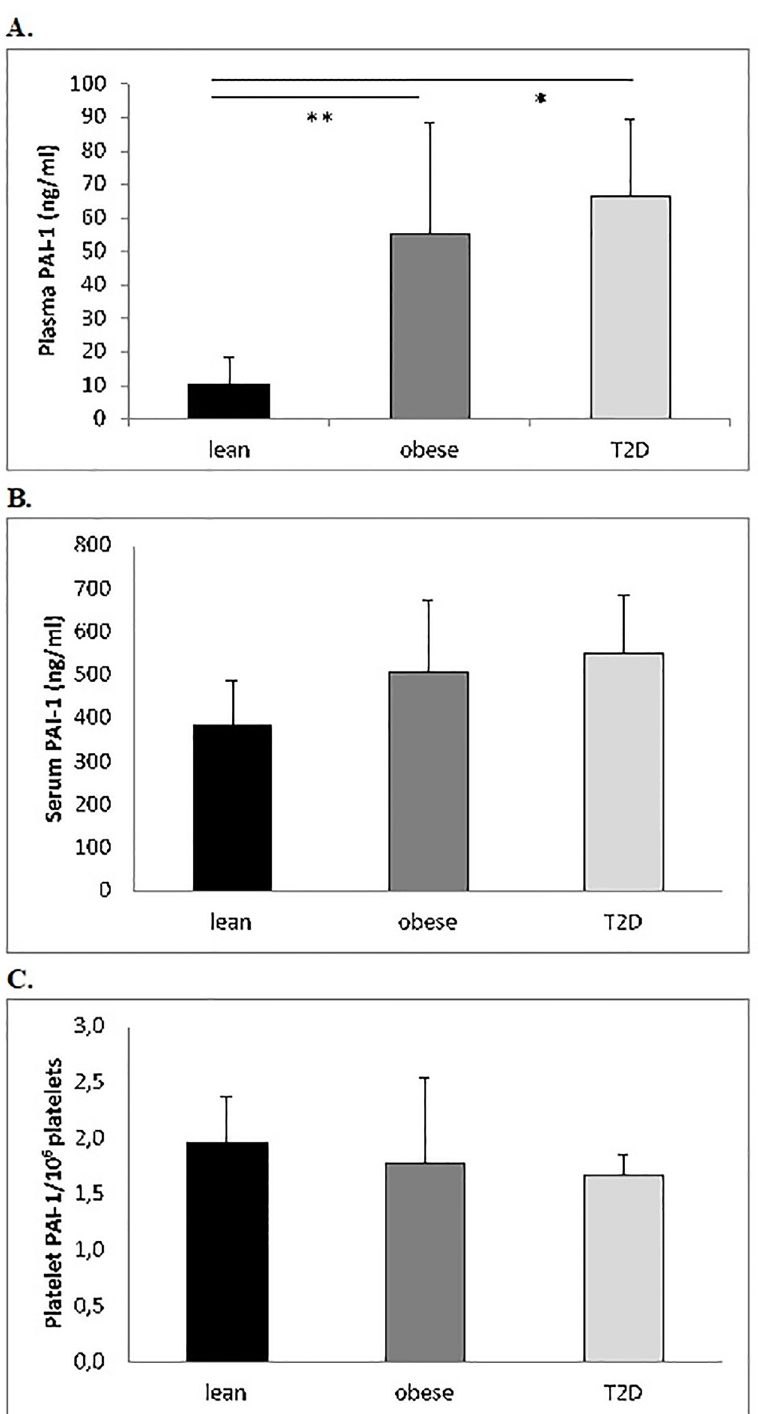
Fig 1. Pool of PAI-1 in A. plasma, B. serum and C. platelets in T2D patients, lean and control participants. There was a significant increase of plasma PAI-1 in participants with T2D and obese non-diabetic control subjects compared with lean control subjects (T2D n = 6, obese n = 7 and lean control subjects n = 8). � P ˂ 0.001, �� P ˂ 0.001. B. No significant difference in serum PAI-1 between the three groups (T2D n = 6, obese n = 7 and lean control subjects n = 8). C. There was no significant difference in platelet PAI-1 between the three groups (T2D n = 4, obese n = 5 and lean control subjects n = 8). Abb. PAI-1 = plasminogen activator inhibitor -1; T2D = type 2 diabetes.